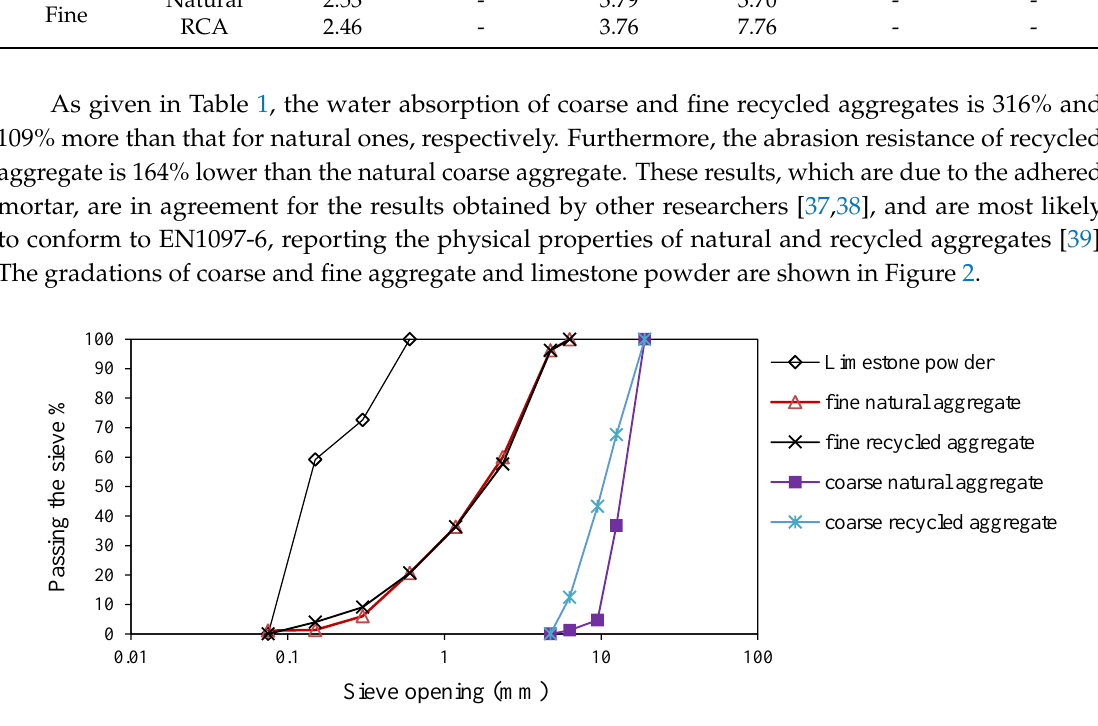
Figure 2. Gradations of coarse and fine aggregate and limestone powder.